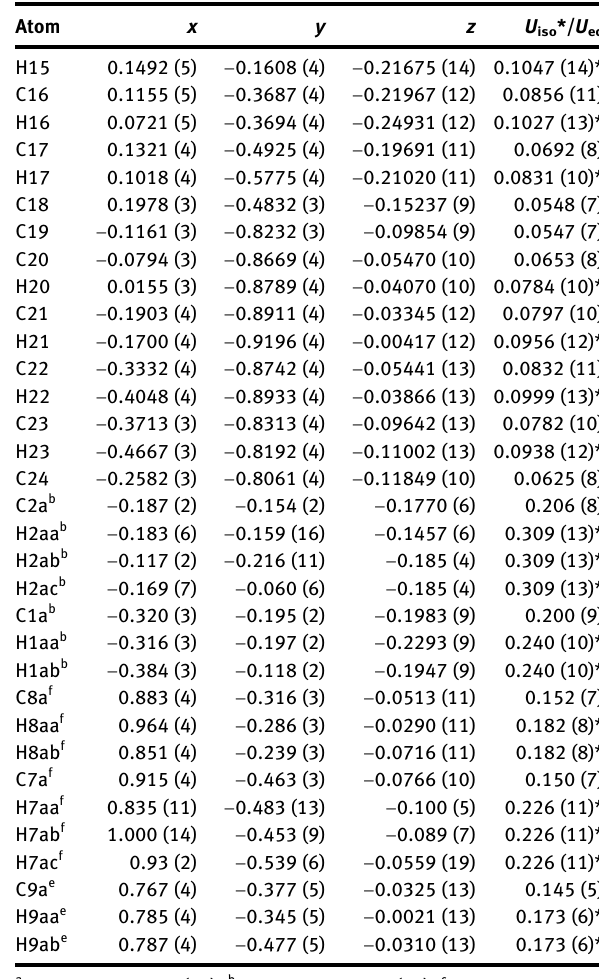
Table  : Fractional atomic coordinates and isotropic or equivalent isotropic displacement parameters (Å 